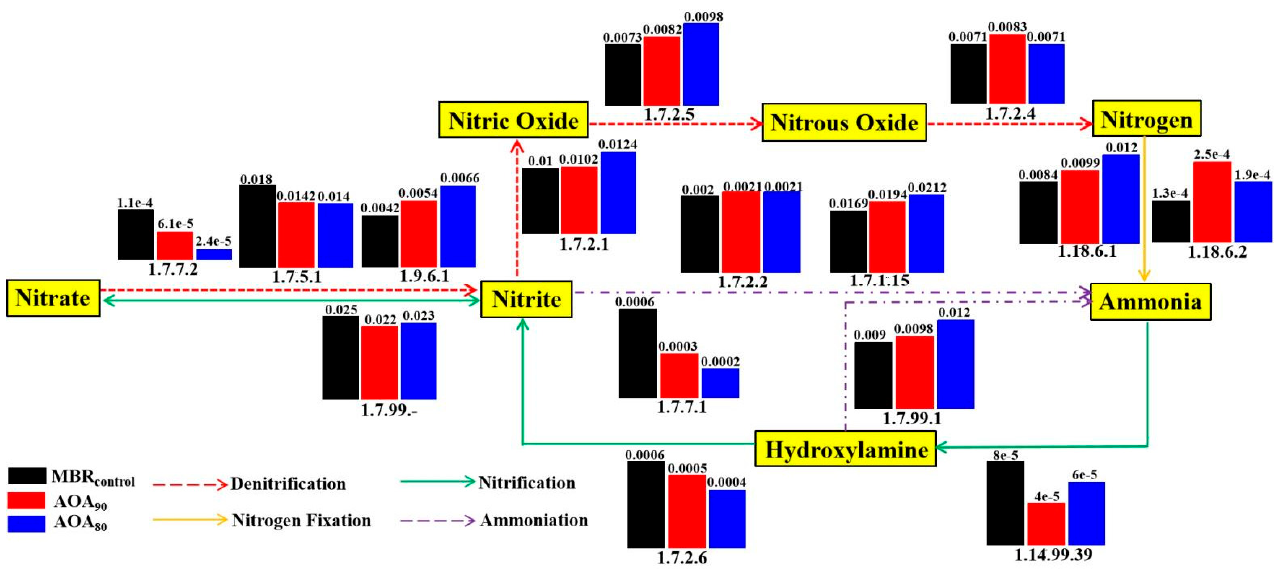
Figure 7. Diagram of nitrogen pathway and the average relative abundance of genes encoding enzymes (identified by their EC number) in MBR control , AOA 90 and AOA 80 .